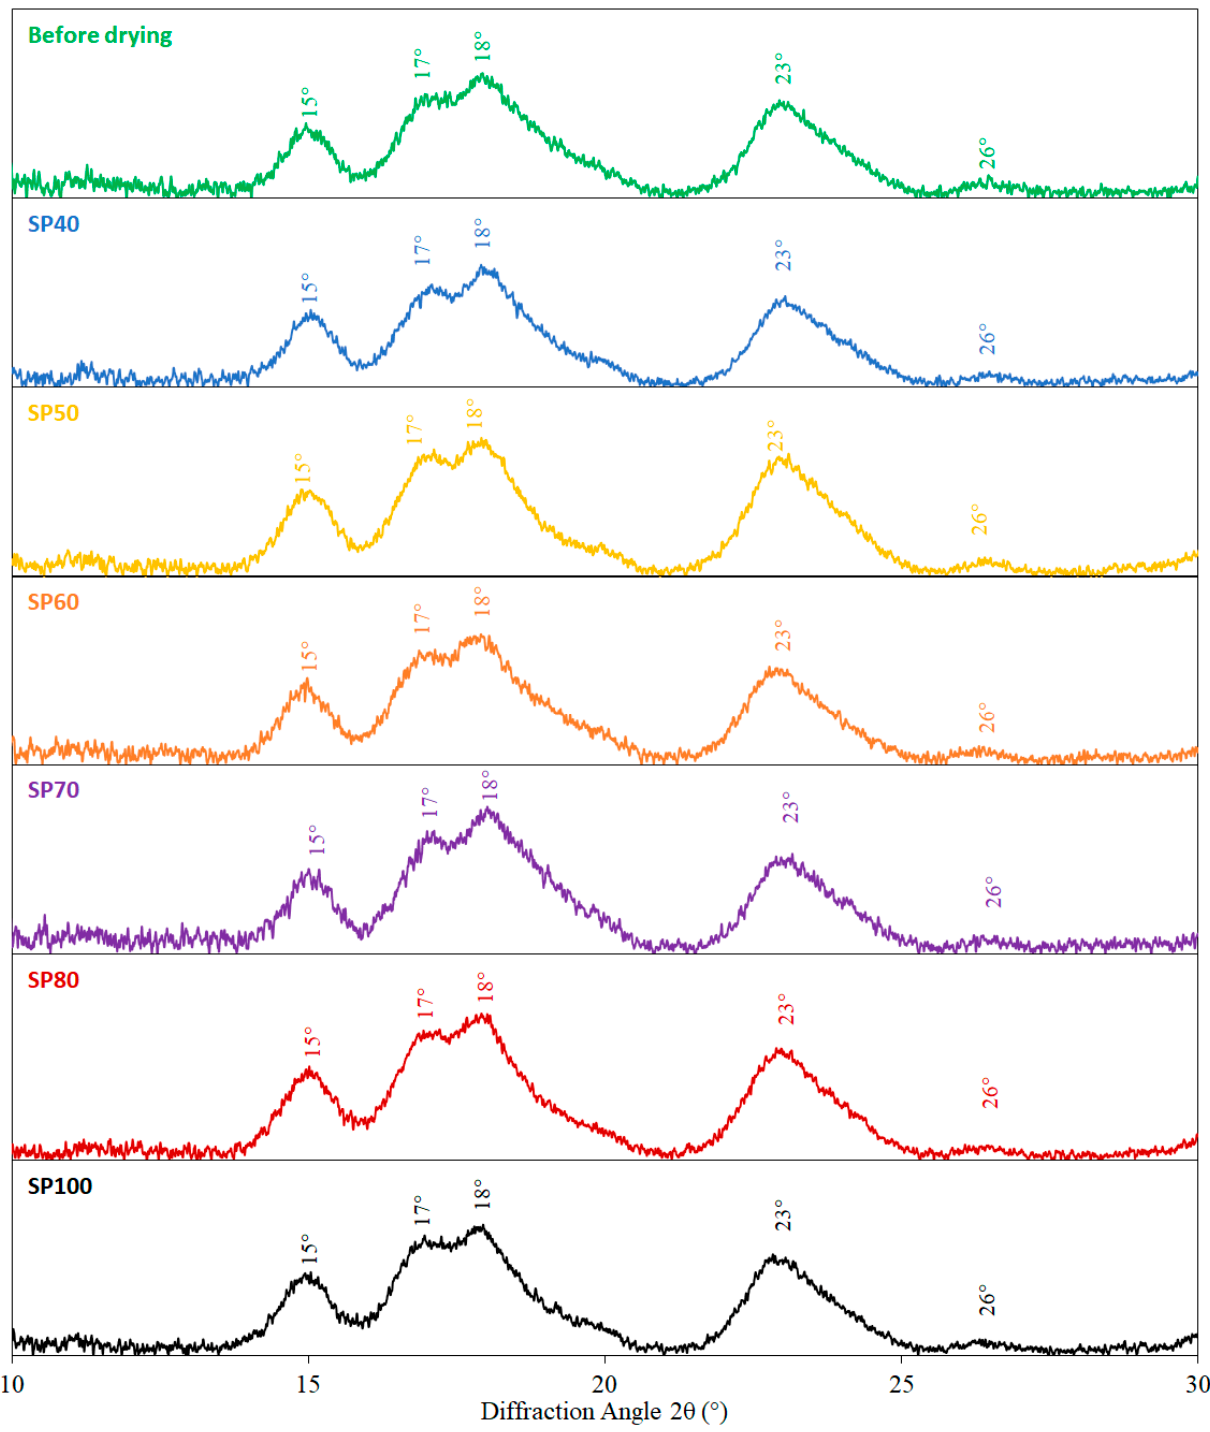
Figure 4. X-ray diffractograms (XRD) of native (Before Drying) and spray dried waxy rice starches. Both polarized microscopy and XRD represent excellent qualitative tools to determine the retention of crystallinity and the crystalline structure type. Differential Scanning Calorimetry (DSC) is a quantitative tool used to determine the degree of crystallinity and various pasting parameters. Upon prolonged heating, starch generally undergoes gelatinization. This is an endothermic process that corresponds to the loss of starch crystallinity after being exposed to heat and moisture treatment [35]. As starch granules change from a semi-crystalline to amorphous phase, breakage of the crystallites occurs. This is a mo- lecular disordering transition [17]. However, based on our study (Table 3), there is no significant difference in the gelatinization characteristics (T O , T P , T C , T C- T O and △ H) be- tween the native waxy rice starch and the spray-dried waxy rice starches. These results also correspond to that of native waxy rice starch. In the experimental findings reported